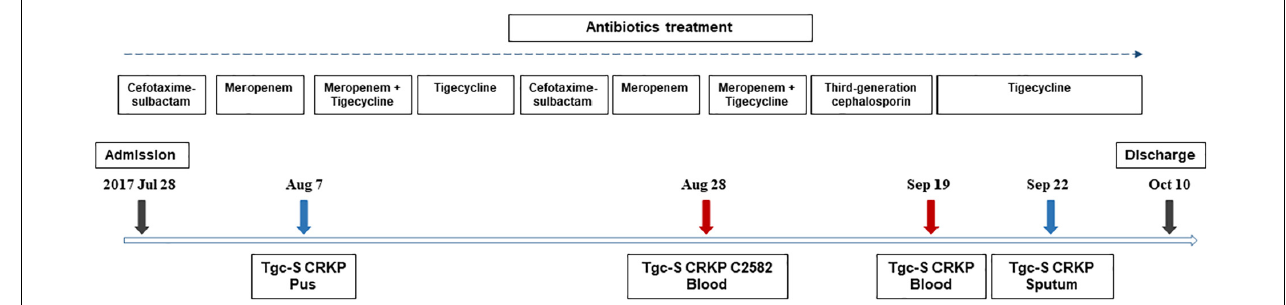
Frontiers in Microbiology |